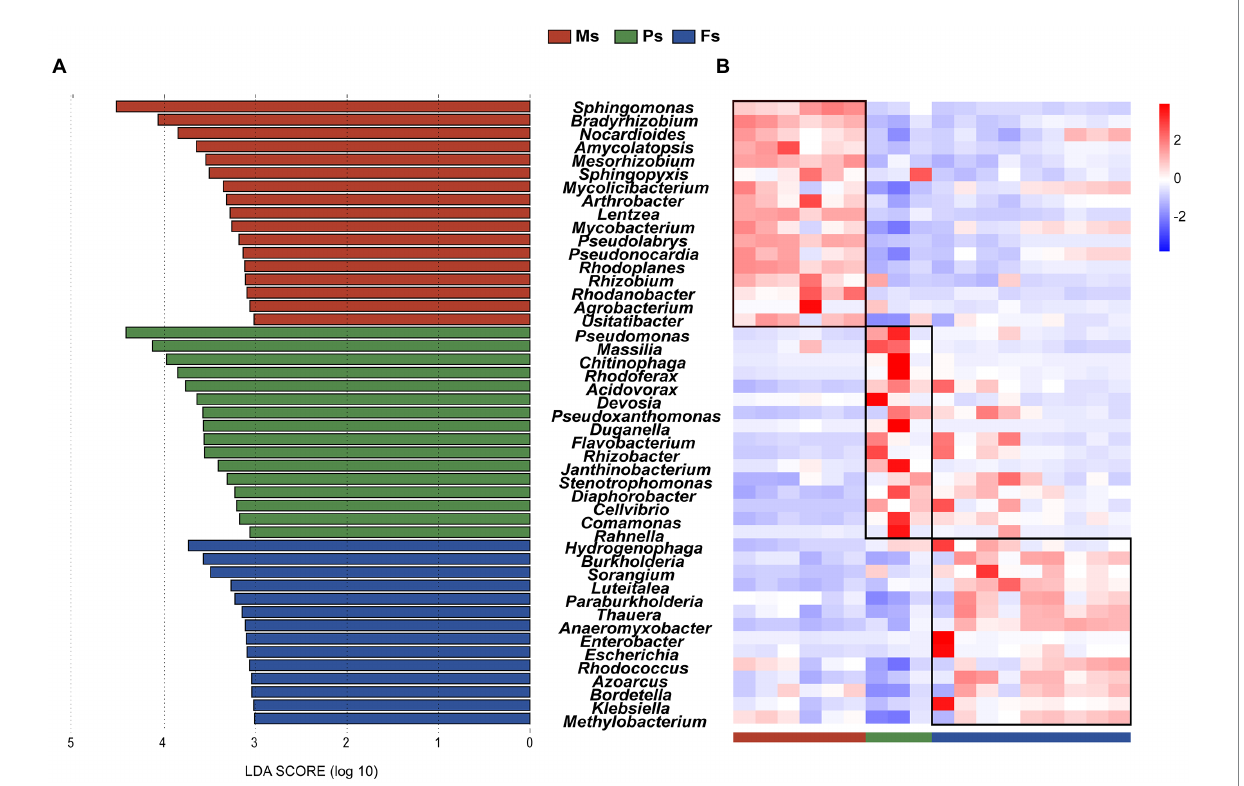
FIGURE 4 Identification of key microbial biomarkers associated with Morchella sextelata growth stages. (A) LEfSe to identify characteristic biomarkers between different stages. Only microbial taxa with a LDA score > 3 are shown. (B) Heatmap showing the relative abundances ( Z -scores) of 47 stage-associated